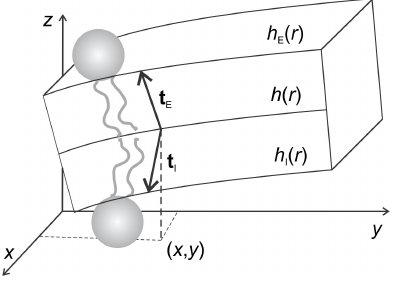
Figure 8. Schematic presentation of a perturbed lipid bilayer with local directors t E and t I and height profiles h E and h I of the external and internal membrane leaflet, respectively. The average bilayer height is h = ( h E + h I ) /2. Adapted with permission from ref. [22]. 2006